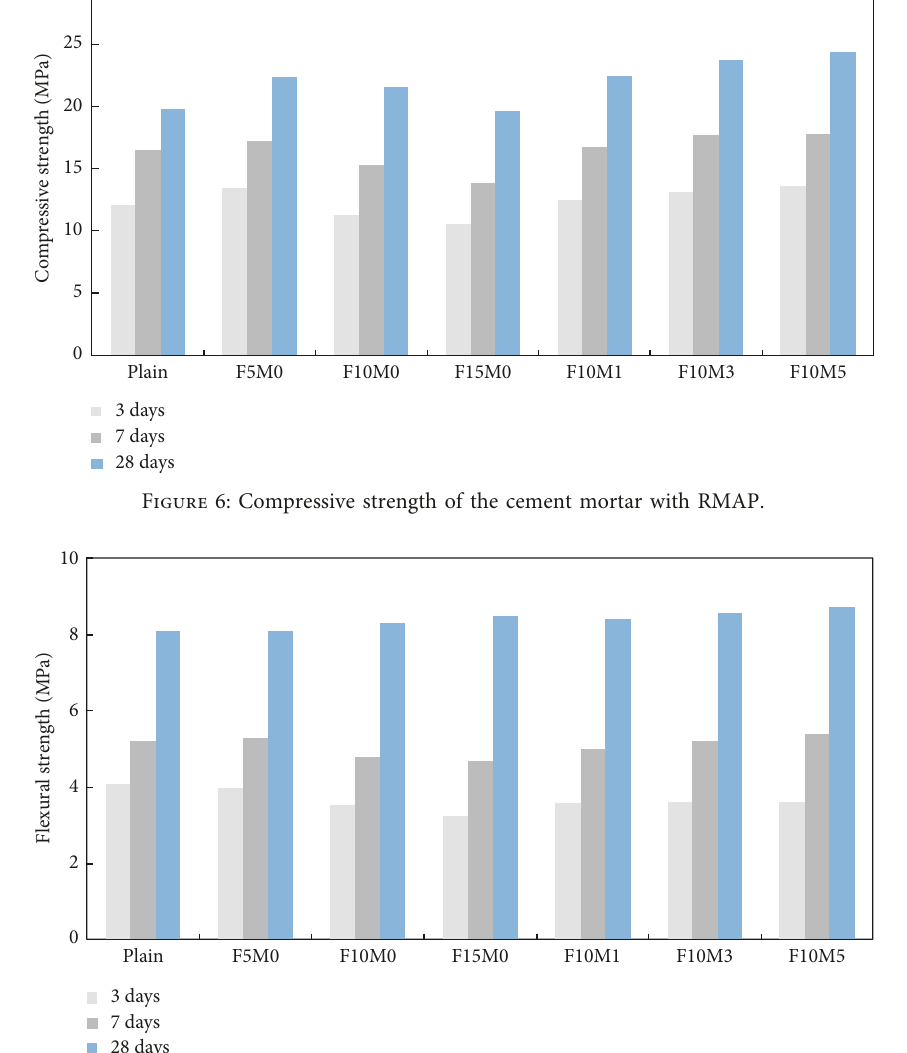
Figure 7: Flexural strength of the cement mortar with